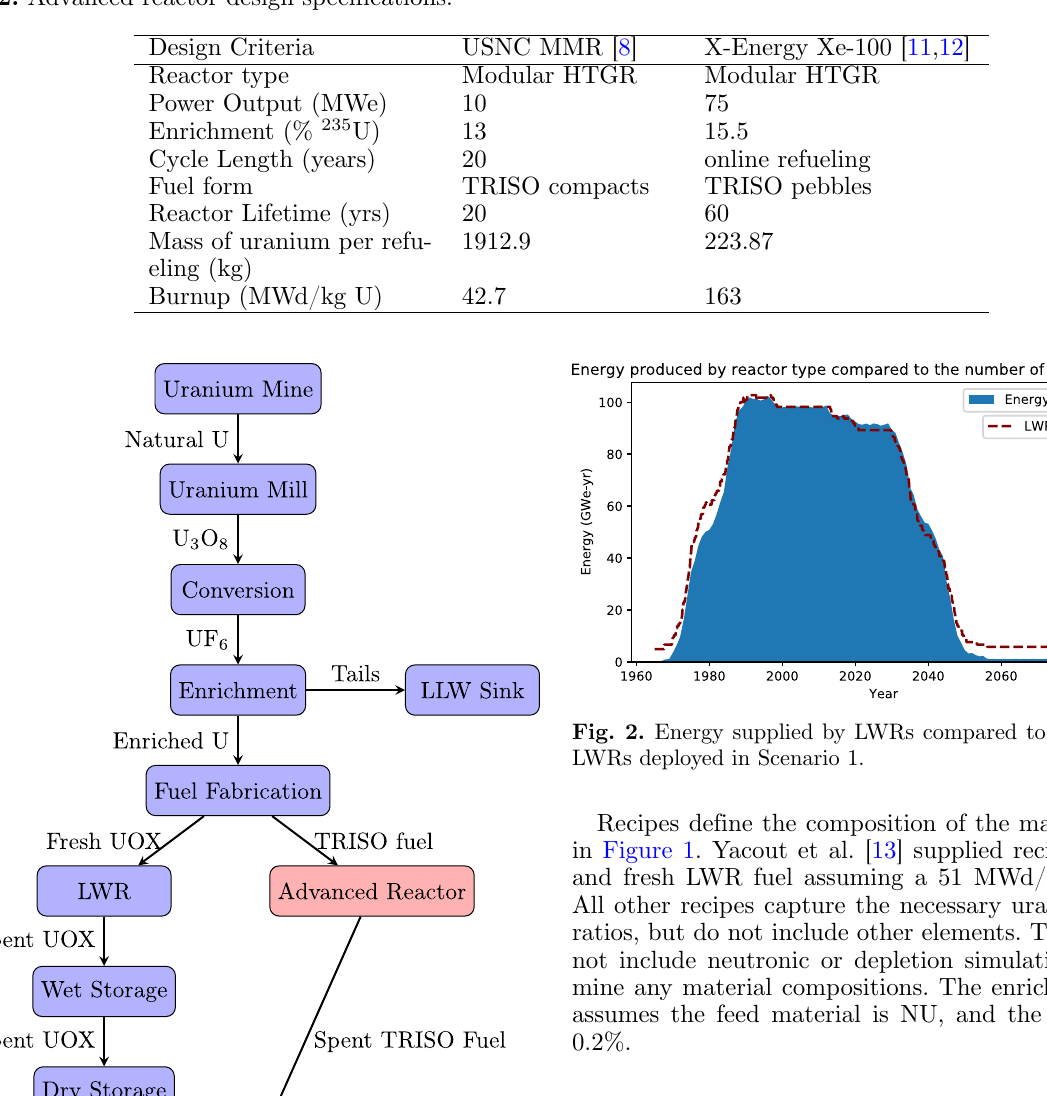
Table 2. Advanced reactor design specifications.